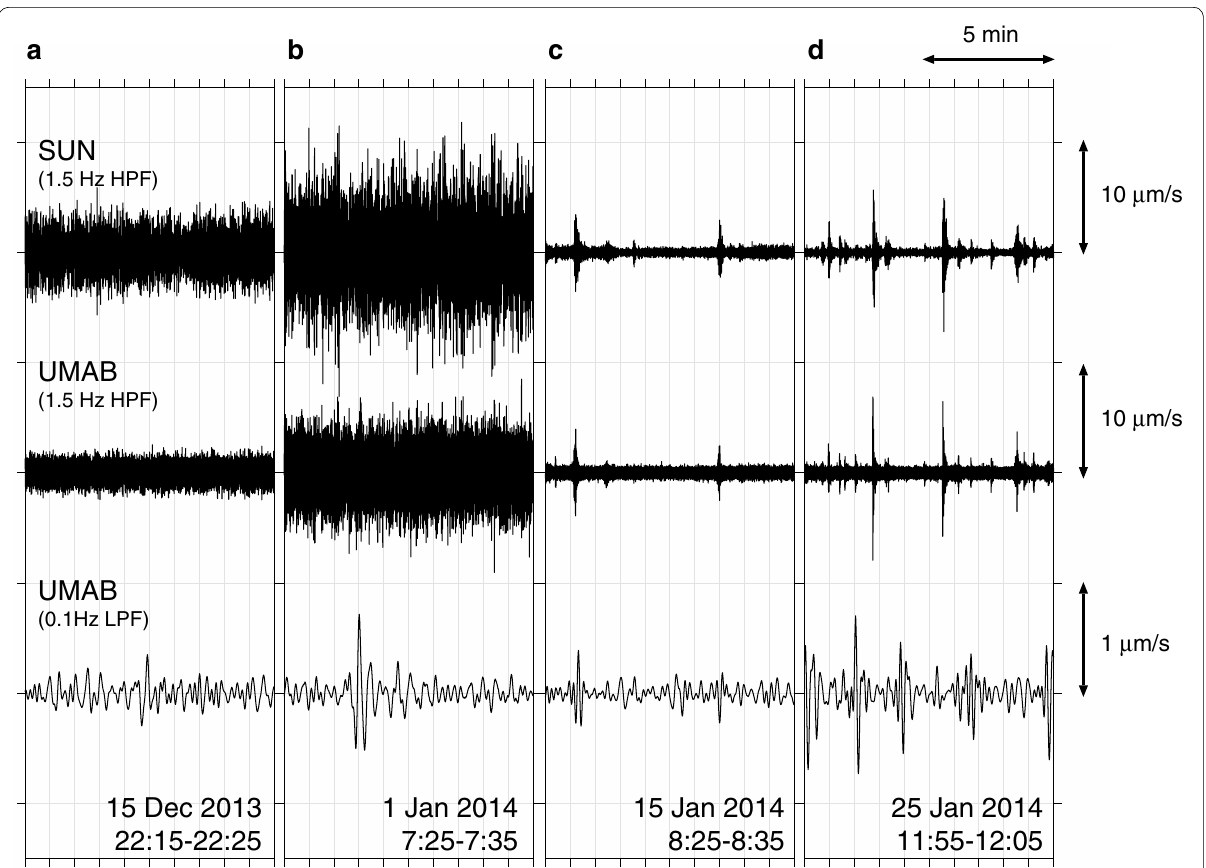
Fig. 4 Waveforms of continuous tremors. Waveforms of continuous tremors recorded at a 22:15–22:25 on 15 December 2013, b 7:25–7:35 on 1 January 2014, c 8:25–8:35 on 15 January 2014, and d 11:55–12:05 on 25 January 2014. The traces, from top to bottom, are a 1.5-Hz high-pass vertical seismogram at SUN, a 1.5-Hz high-pass vertical seismogram, and a 0.1-Hz low-pass vertical seismogram at